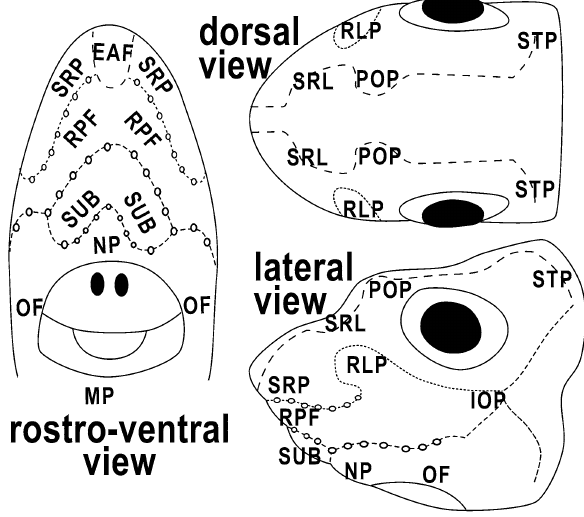
Figure 2. Gross anatomy of the head of the system of Ampullae of Lorenzini of Chimaera monstrosa . Lateral line canals are shown as dashed lines and circles. EAF: ethmoid cluster; IOP: infraorbital cluster; MP: mandibular cluster; NP: nasal cluster; OF: oral cluster; POP: preorbital cluster; RLP: rostrolateral cluster; RPF: rostral cluster; SRL: supra-rostrolateral cluster; SRP: suprarostral cluster; STP: supratemporal cluster; SUB: subrostral cluster.